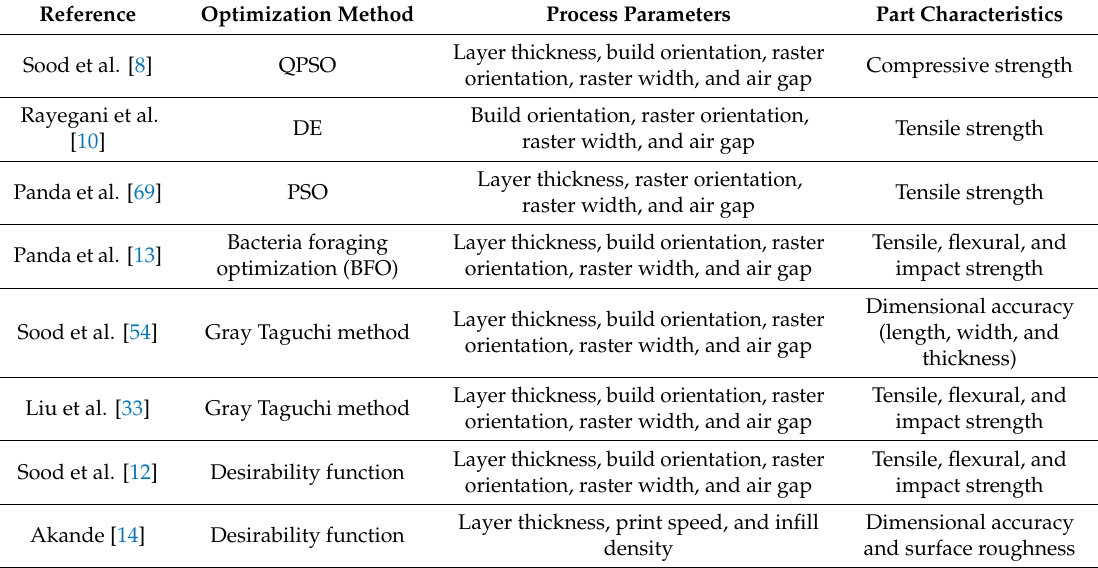
Table 3. Research on numerical optimization. QPSO—quantum-behaved particle swam